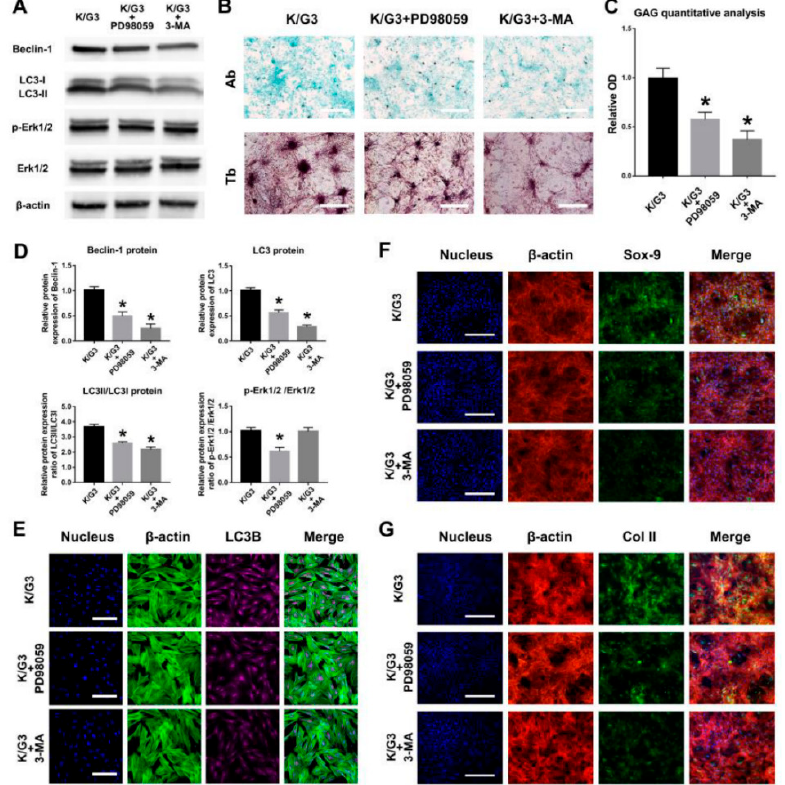
Figure 8. The correlation between the autophagy and chondrogenesis induced by rGO@Ge in ADSCs cultured with K/G3 medium. ( A ) The Western blot analysis on the Erk1/2 signal pathway and autophagy associated proteins in ADSCs co-cultured with PD98059 or 3-MA in K/G3 medium. ( B ) The Ab and Tb stainings of the ADSCs chondrogenesis treated with K/G3, K/G3+PD98059 and K/G3+3-MA medium, bar: 500 µ m. ( C ) The quantitative analysis of the alcian blue staining to evaluate the GAG content. * p < 0.05 indicates a significant difference compared to the K/G3 group. ( D ) The quantitative analysis of the Beclin-1, LC3, LC3II/LC3I, p-Erk1/2 /Erk1/2. * p < 0.05 indicates a significant difference compared to the K/G3 group. ( E ) The LC3B immunofluorescent staining was used to test the autophagic activities, bar: 200 µ m. Immunofluorescence staining of the chondrogenic markers Sox-9 ( F ) and Col II ( G ) clarified the difference of ADSCs chondrogenesis in three groups, Bar: 200 µ